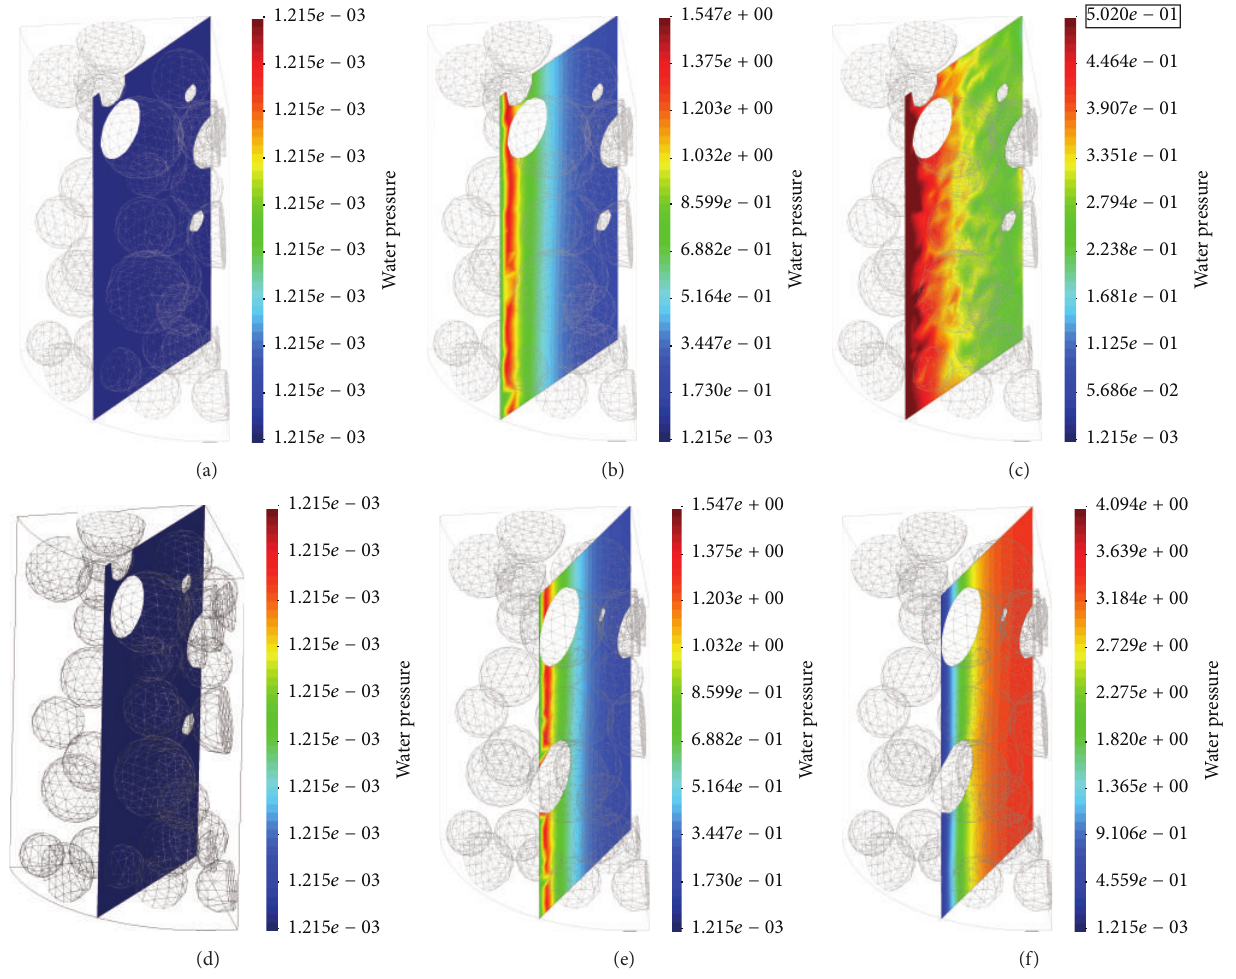
Figure 11: Water pressure distribution inside the sample at different temperatures for the two samples, with and without PP fibres: at 20 ∘ C with PP (a); at 200 ∘ C with PP (b); at 350 ∘ C with PP (c); at 20 ∘ C without PP (d); at 200 ∘ C without PP (e); at 350 ∘ C without PP (f).